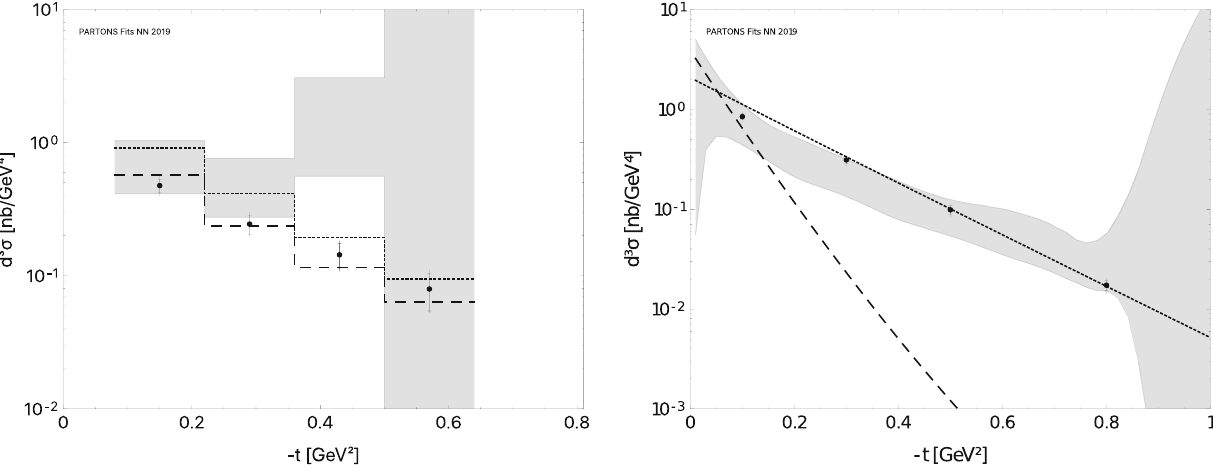
Fig. 15 Comparison between the results of this analysis, the selected results of this analysis and the GPD model evaluations are 3D integrals GPDmodelsandtheexperimentaldatapublishedbyCOMPASS inRef. in four bins of the (ν, Q 2 , t ) phase-space, where ν is the virtual-photon [36] for d 3 σ ± energy. The ranges of those bins are specified in Ref. [36]. For further (left) and by H1 in Ref. [39] for d 3 σ + at x Bj = 0 . 002 UU UU description see the caption of Fig. and Q 2 = 10 GeV 2 (right). In the left plot, the experimental data, the